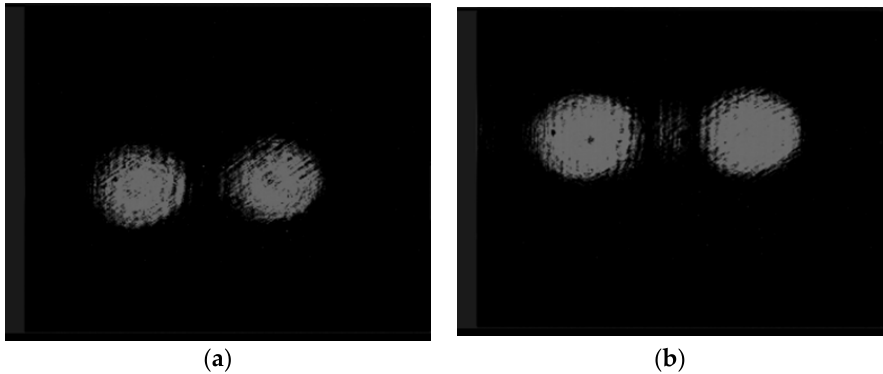
Figure 12. Intensity distributions after passing the blazed grating at a distance of ( a ) 60 mm and ( b ) 75 mm.